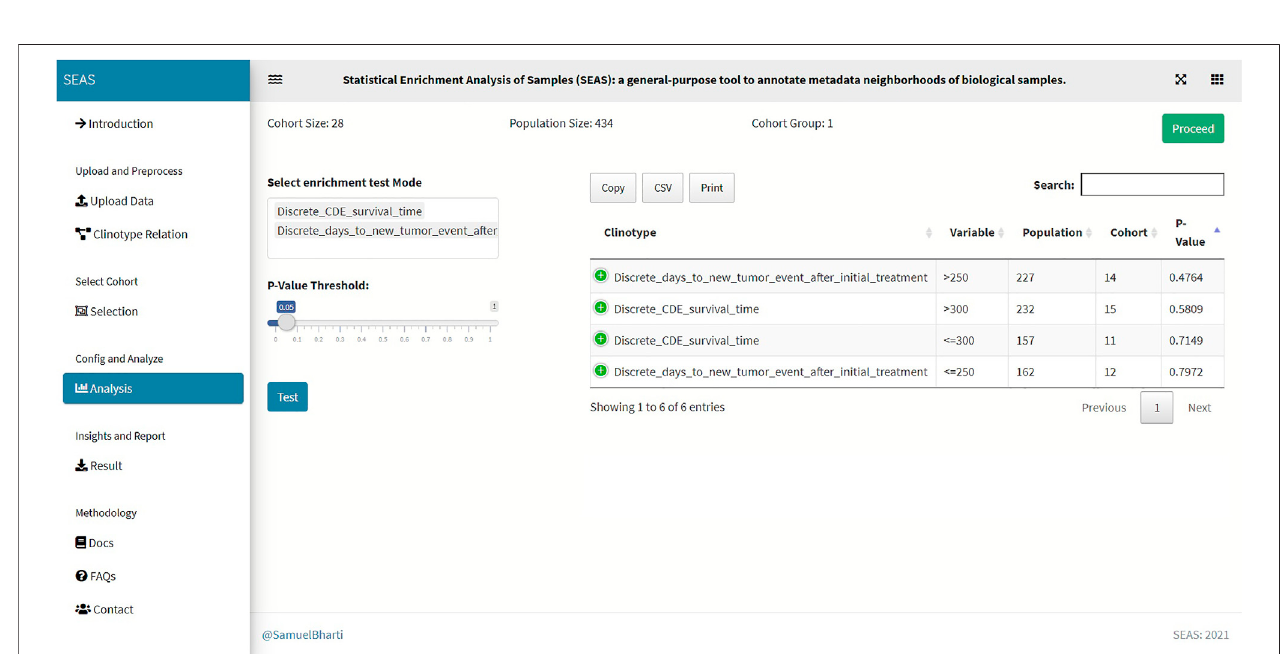
FIGURE 5 | SEAS identi fi es enriched clinical features for the subcohort in Figure 4 .